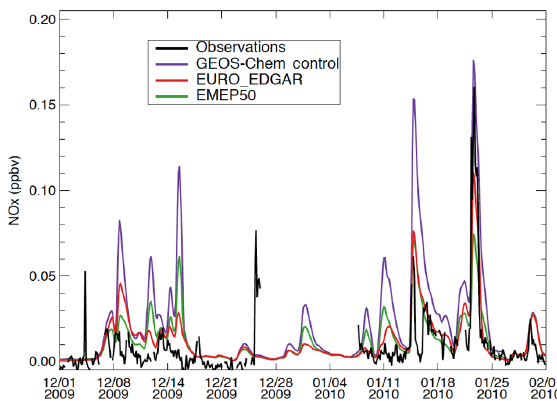
Figure 2. Time series of surface NO x mixing ratios over Sum- mit from observations, GEOS-Chem model control simulations, EURO_ EDGAR, and EMEP50 during 1 December 2009–31 Jan- uary 2010. EURO_EDGAR represents simulations with anthro- pogenic NO x emissions over Europe following EDGAR v4.2, while EMEP50 denotes simulations with anthropogenic NO x emissions from the EMEP emission inventory over Europe reduced by 50%; other model configurations are identical to the control